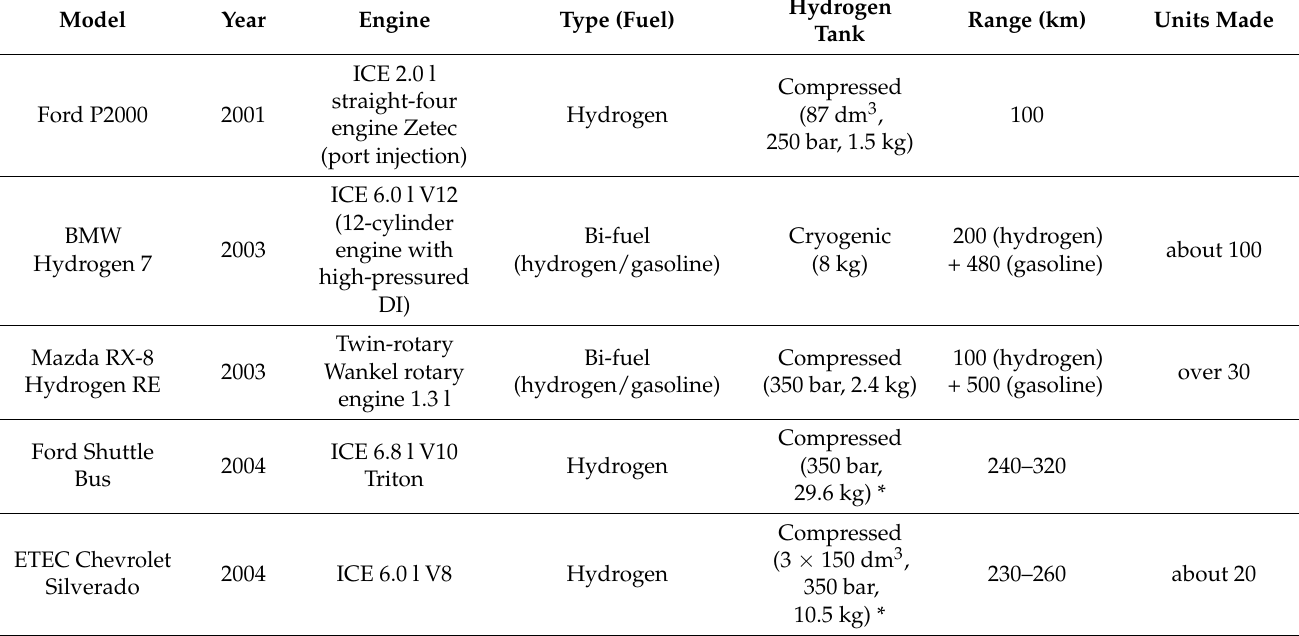
Table 2. Basic parameters of hydrogen combustion vehicles produced in the 21st century